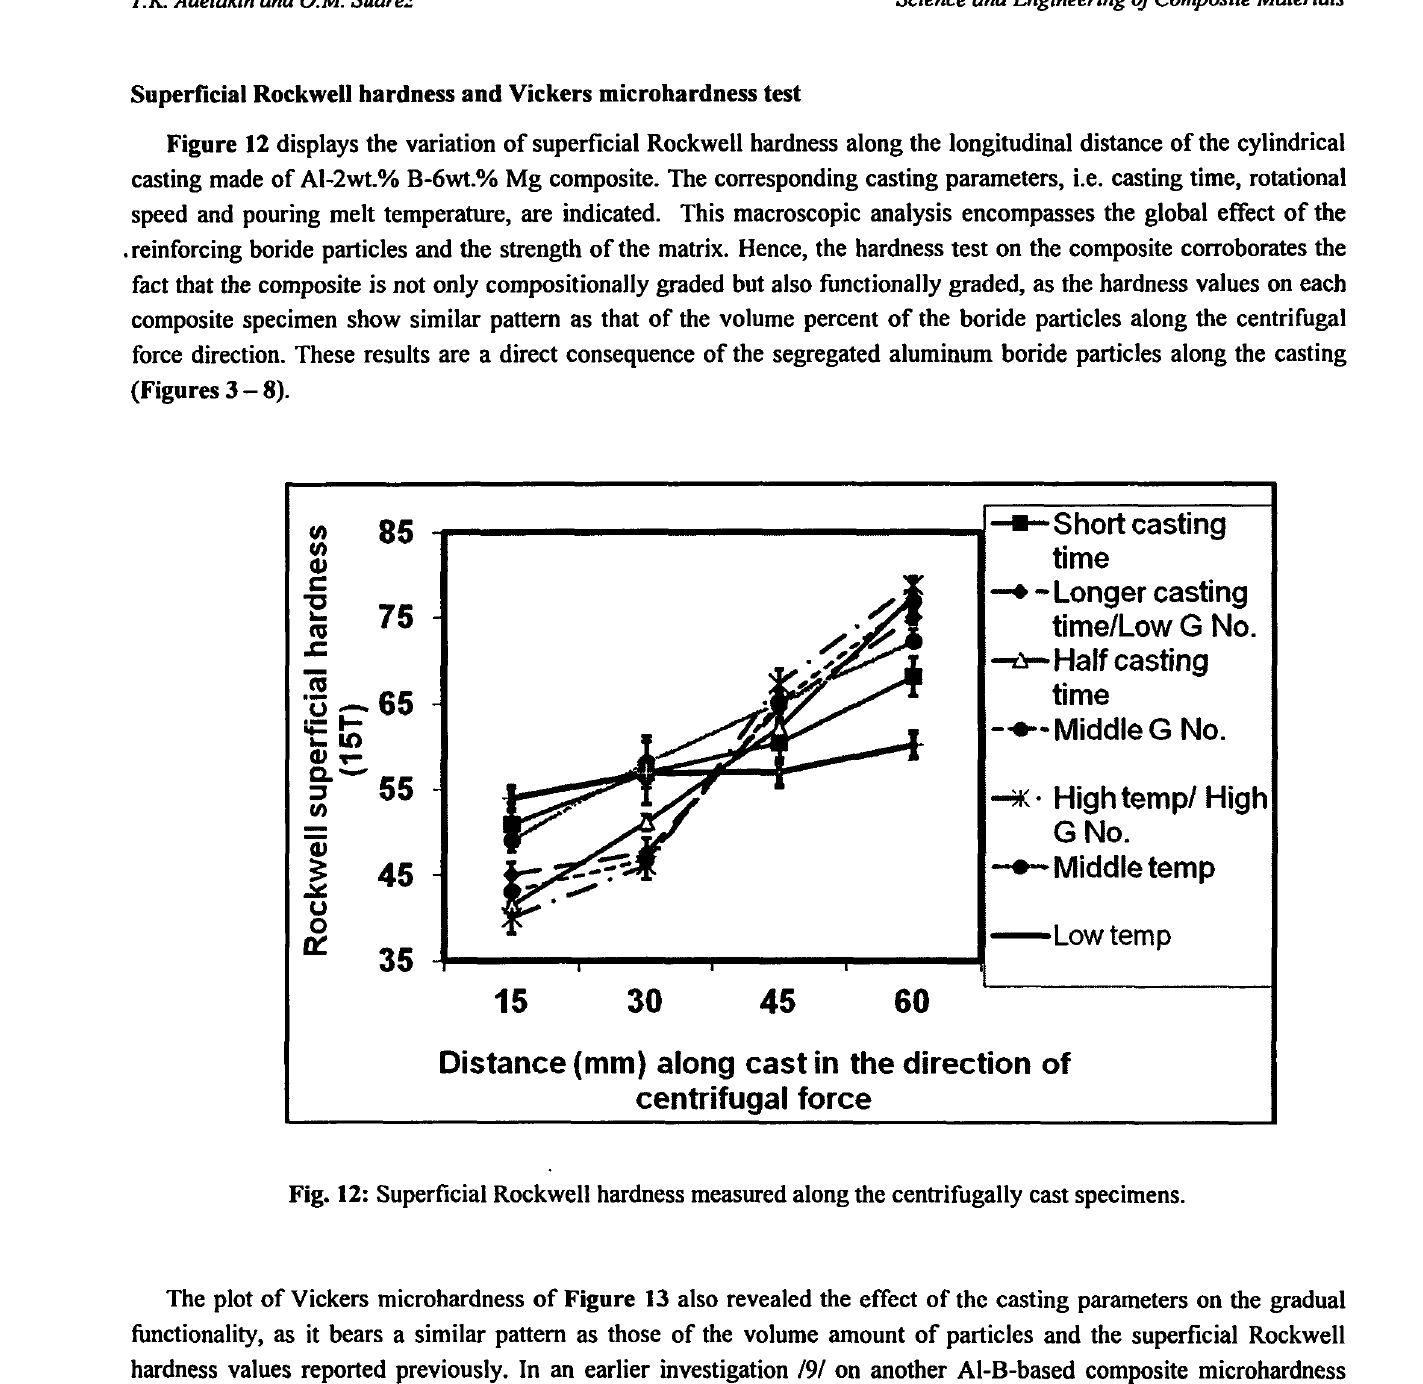
Fig. 12: Superficial Rockwell hardness measured along the centrifugally cast